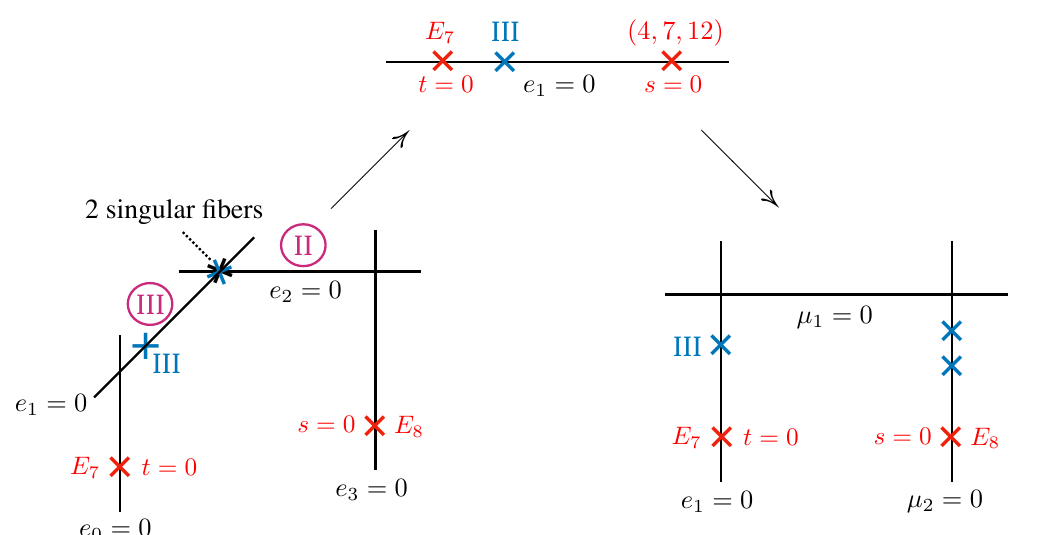
Figure 5 . Blowup of degeneration (4.45) into the non-Kulikov Weierstrass model (4.47)(left), followed by blowdowns and base change (top) and final blowup into a Type II Kulikov Weierstrass model